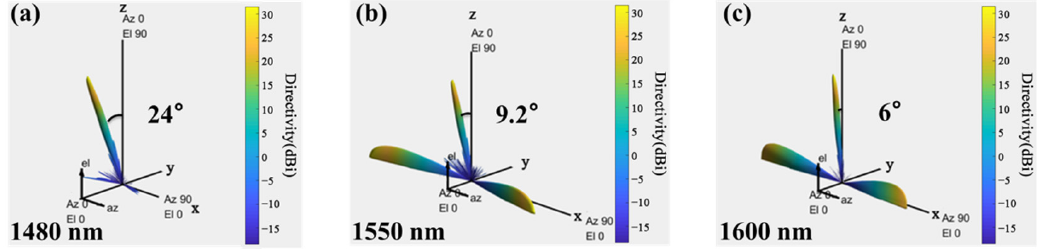
Figure 11. Beam formed at: ( a ) 1480 nm; ( b ) 1550 nm; ( c ) 1600 nm. The far-field spot distribution with different bias angles is simulated using the Lumerical software. Beam synthesis with offset angles at the wavelength of 1480 nm, 1550 nm, and 1600 nm is shown in Figure 12a. There is no gate flap within ±44°, which is the azimuth angle ( Φ ) range of the OPA. The azimuth scanning angle ( Φ ) of the OPA is in the range of 88.2 to 95.4° and increases with the decrease in the input signal wavelength, as shown in Figure 12b.